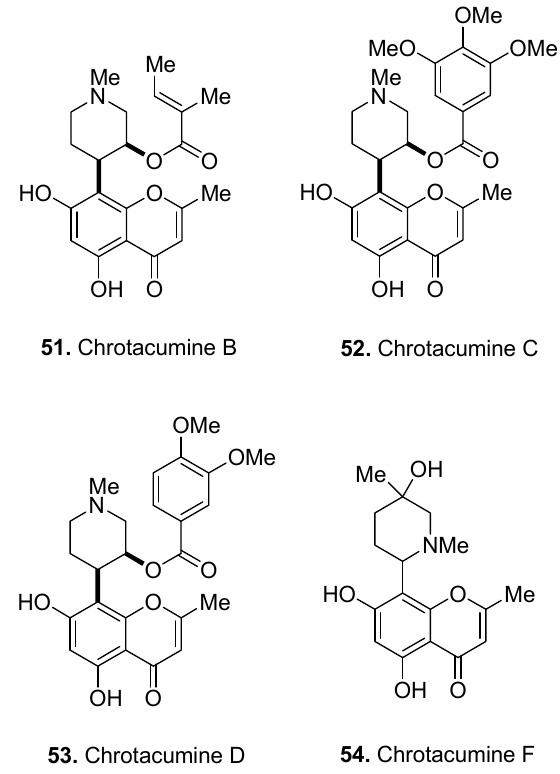
Figure 21. Chrotacumine B ( 51 ), C ( 52 ), D ( 53 ), and F ( 54